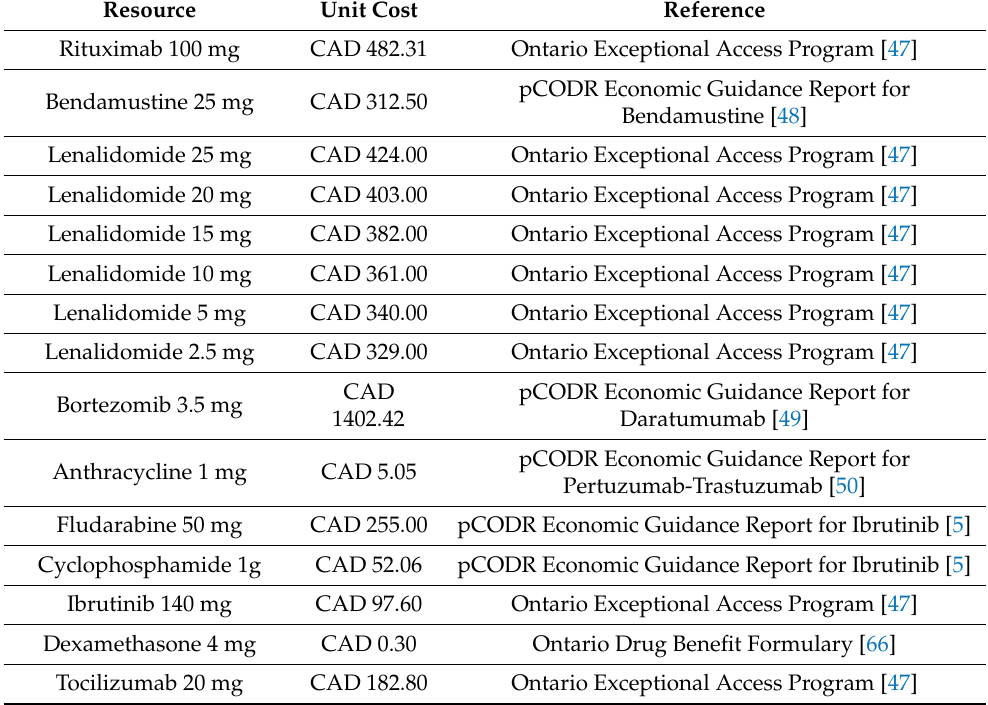
Table A3. Unit drug costs.